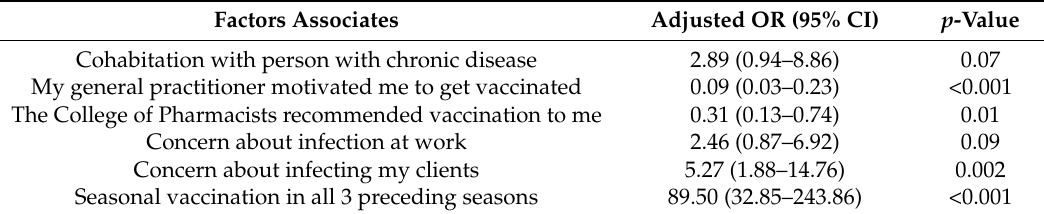
Table 5. Influenza vaccination coverage in community pharmacists in the 2013–2014 season according to attitudes towards influenza